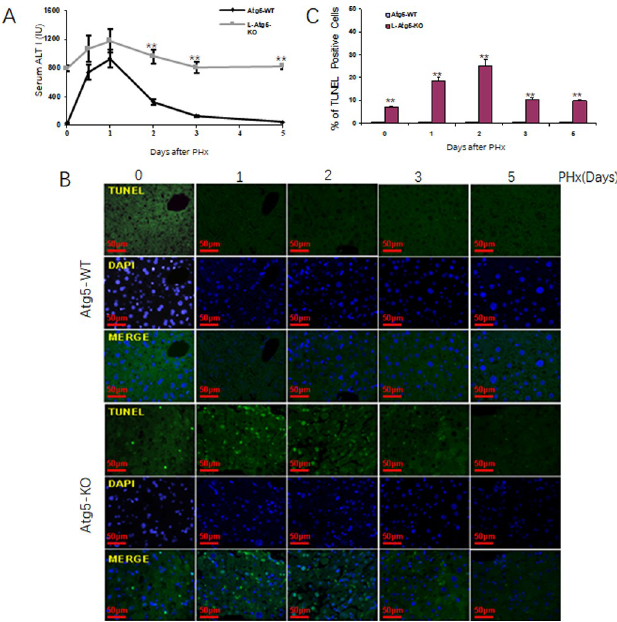
Fig 4. Induction of apoptotic in the liver of L-Atg5-KO mice after PHx. (A) Serum ALT level was measured at indicated time pointed. Five mice were analyzed per time point and the results represented the mean. (B) TUNEL staining in liver tissue section of L-Atg5-KO mice at different time points after PHx. (C) Percentage of TUNEL- positive cells after PHx. The results represented the mean of 20 different viewing fields statistically significant. The results represent the mean ± s.e.m. of at least three mice. � , p < 0.05; �� , p < 0.01.